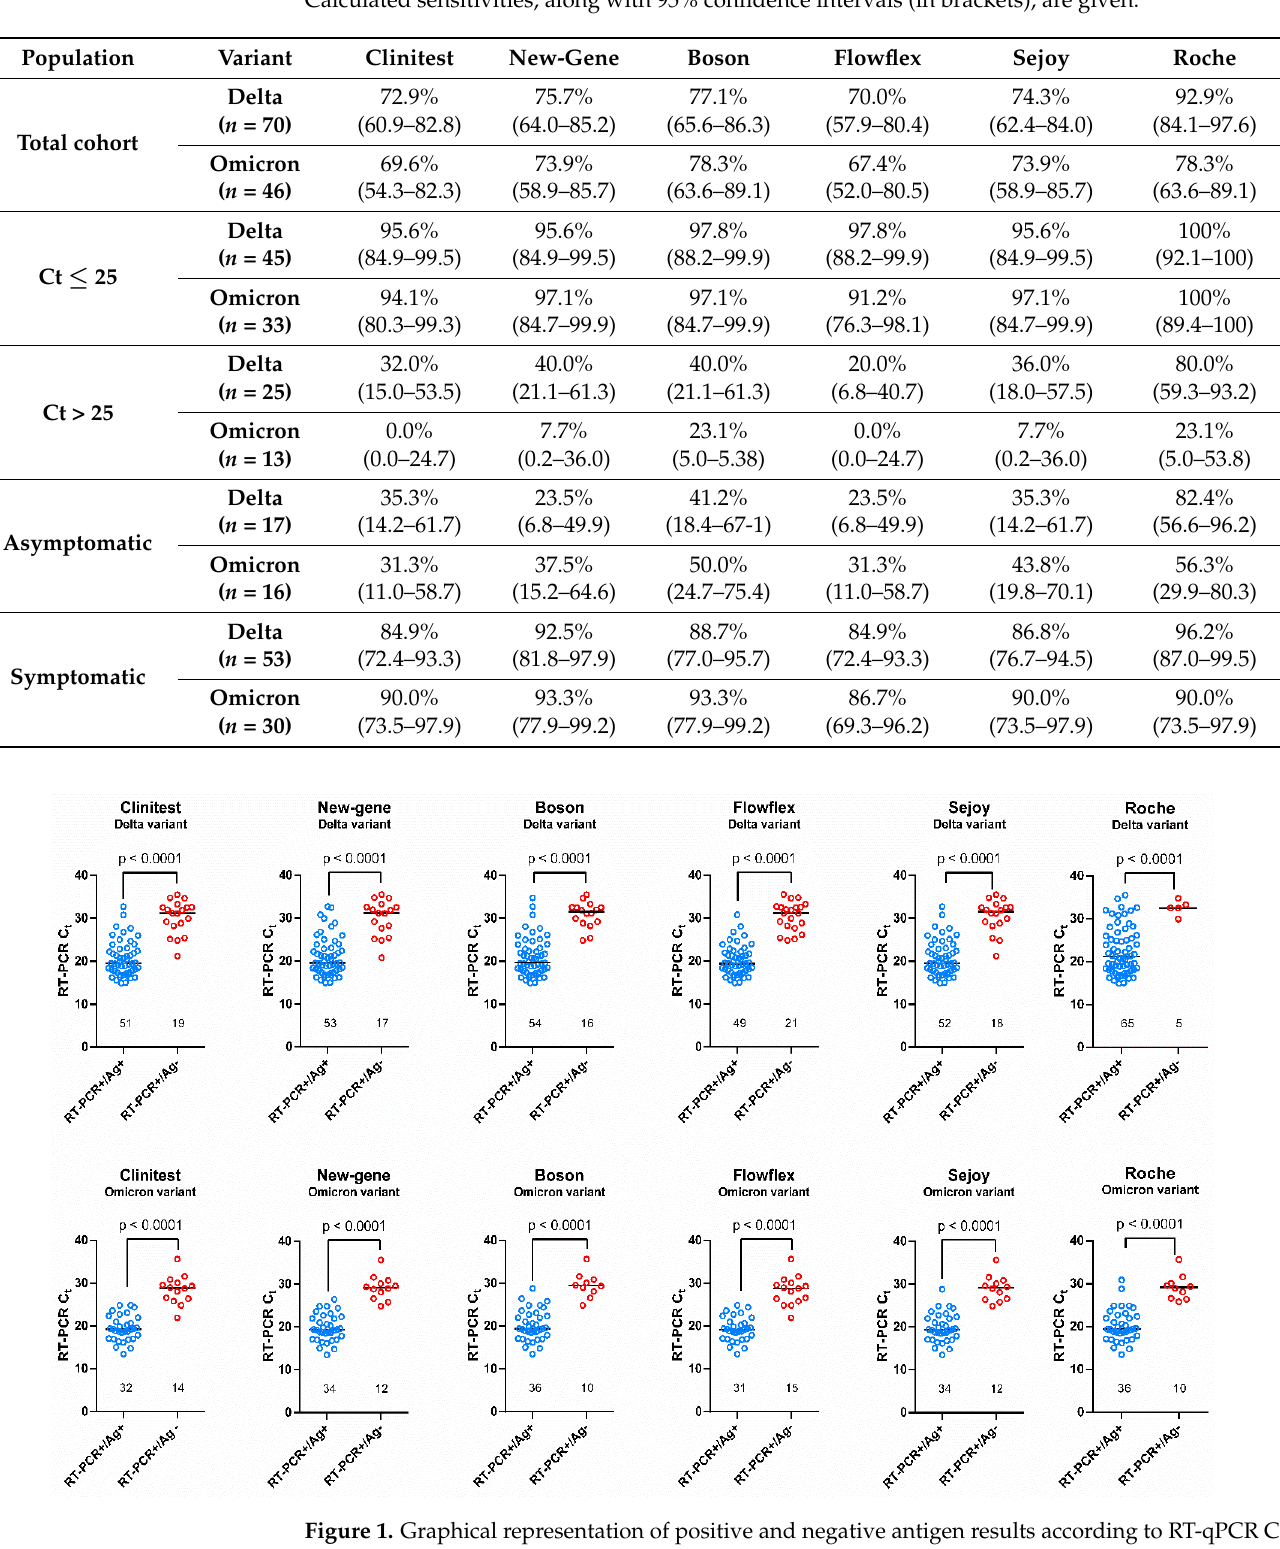
Table 1. Comparison of the sensitivity of 5 RAD tests between the Delta and Omicron variants. Calculated sensitivities, along with 95% confidence intervals (in brackets), are given.